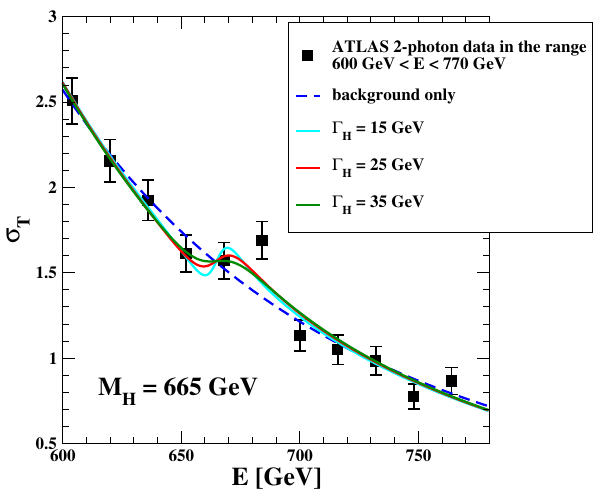
Figure 5. Three fits with Equation (22) to the data in Table 2, transformed into cross sections in fb. With respect to Figure 4, we have reversed the sign of the interference term in Equation (22). For Γ = 15, 25, and 35 GeV, the χ 2 -values are respectively 10.4, 10.1, and H